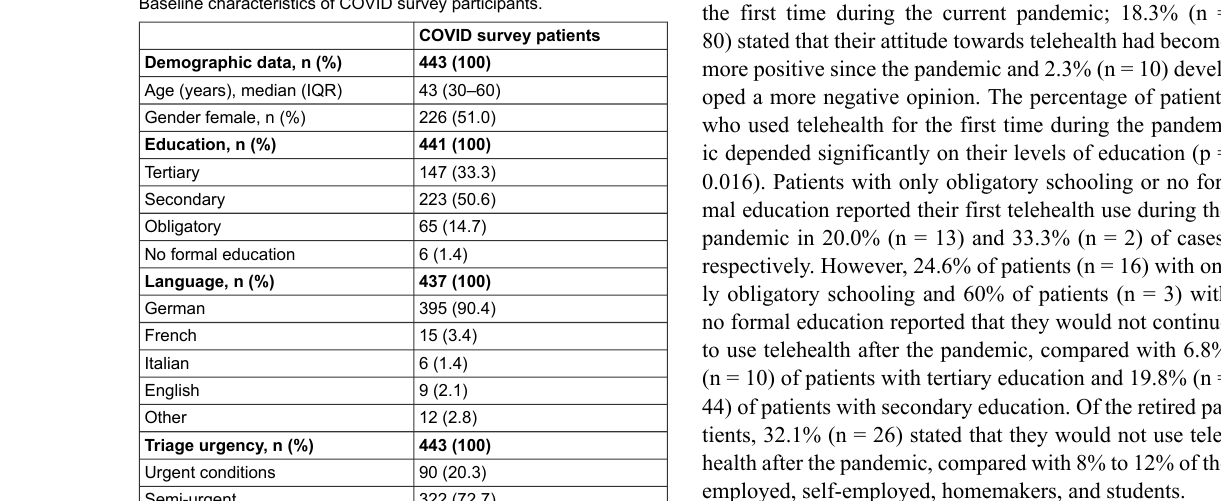
Table 1: Baseline characteristics of COVID survey participants.